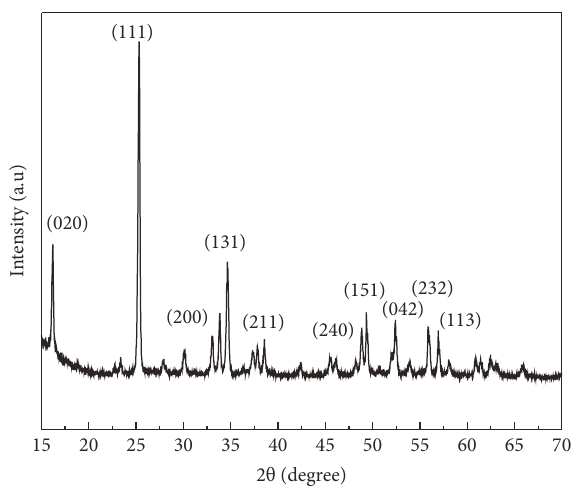
Figure 1: XRD pattern of tungsten oxide